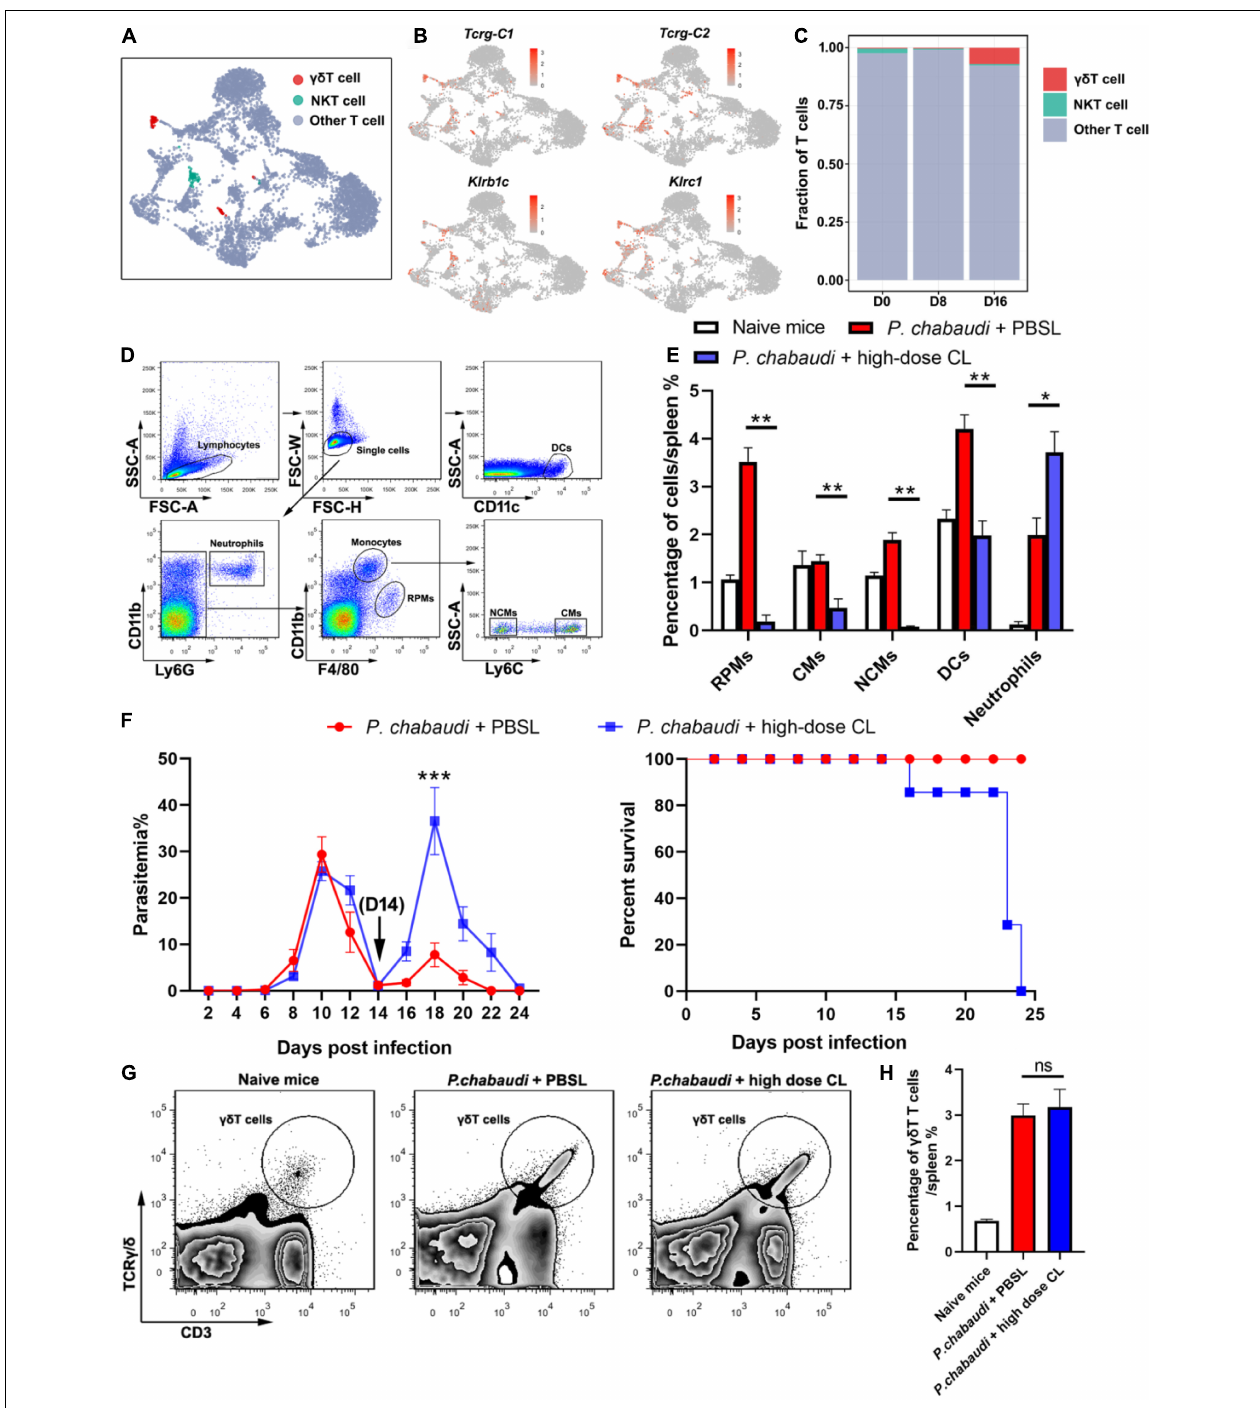
FIGURE 5 | Innate immune cells are essential for the control of P. chabaudi recurrence. (A) UMAP projection plot of T cell populations merged from the three time points. (B) Feature plots depicting single-cell expression of canonical immune cell markers of γδ T cells and NKT cells. (C) Cell abundance frequency of γδ T cells and NKT cells relative to the total number of T cells at each time point. (D) A representative flow cytometry analysis of phagocytic cells, including the RPMs, CMs (classical monocytes), NCMs (non-classical monocytes), DCs and neutrophils. (E) Statistical analysis of the frequency of phagocytic cells in infected mice after treatment with CLs for 48 h. (F) WT mice ( n = 5) were treated with clodronate liposomes (CLs) or control liposomes (PBSLs) on days 14, 17, 20 after the challenge. All the mice were challenged with P. chabaudi on day 0. The parasitemia ( left ) and survival rate ( right ) were monitored. (G) A representative flow cytometry analysis of γδ T cells. (H) Statistical analysis of the frequency of γδ T cells in mice after treatment with CLs for 48 h. Three individual experiments were performed. The data are presented as means ± the SD. ns, not significant; * P < 0.05; ** P < 0.01; *** P < 0.001.